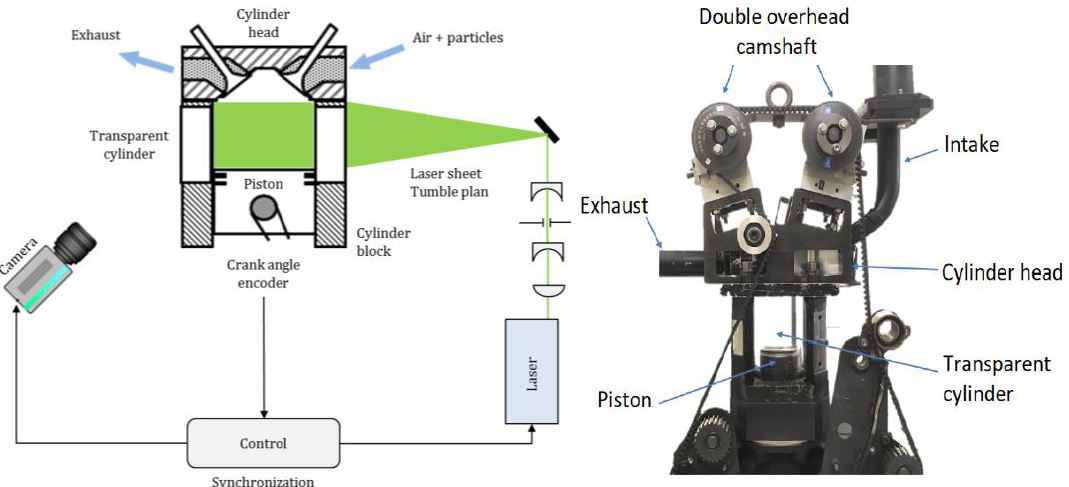
Figure 3. Particle image velocimetry (PIV) measuring system and transparent engine.